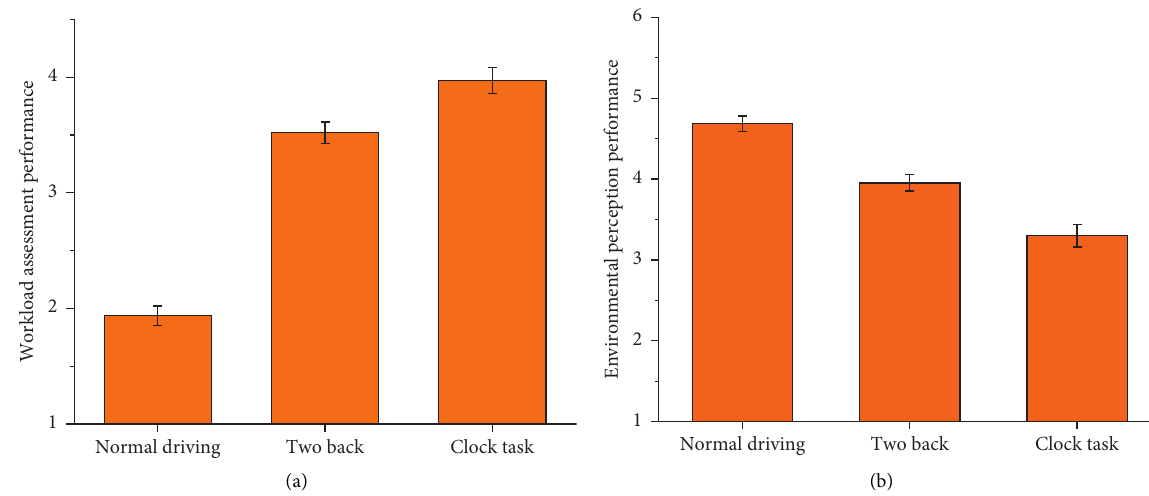
Figure 20: Main effect of the driving tasks on the (a) workload assessment performance and (b) environmental perception